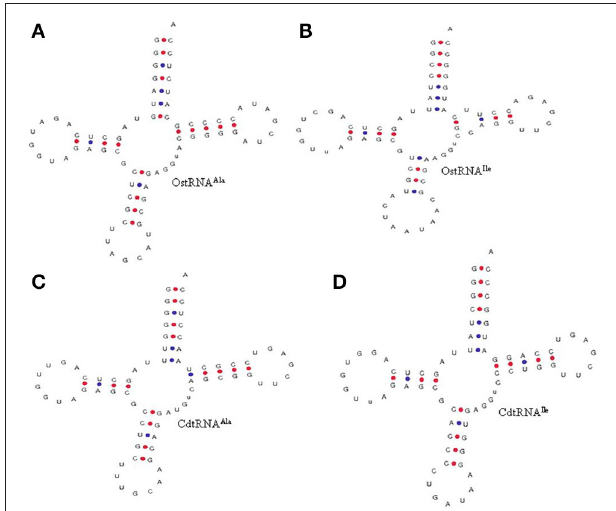
FIGURE 4 | Similarity in the 3 ′ CCA tail of O. sativa (A) tRNA Ala and (B) tRNA Ile with prokaryotic ( Calothrix desertica ) (C) tRNA Ala and (D) tRNA Ile . The tRNA gene sequence in both the organisms contains the 3 ′ CCA tail sequence. Prokaryotic organisms usually lack of nucleotidyl transferase enzyme, which adds the 3 ′ CCA into the tRNA, while eukaryotic organisms contain this enzyme. However, the presence of 3 ′ CCA sequence in the O. sativa tRNA Ala and tRNA Ile gene shows that these tRNA might not require undergoing processing for addition of the 3 ′ CCA tail. The presence of a 3 ′ CCA sequence in O. sativa tRNA Ala and tRNA Ile indicates that O. sativa tRNAs have evolved from common prokaryotic ancestors. CdtRNA; Calothrix desertica tRNA, OstRNA; Oryza sativa